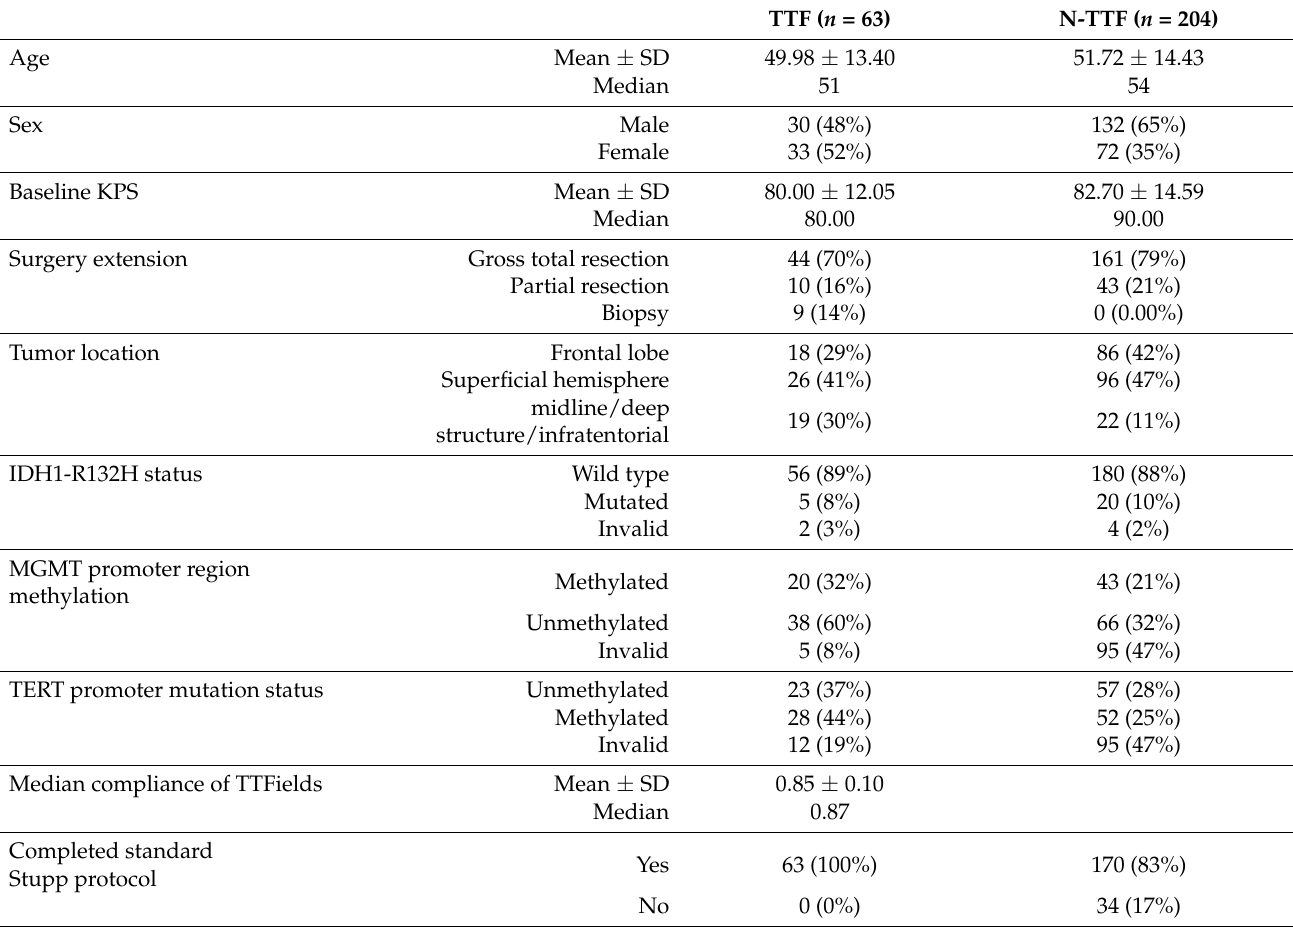
Table 1. Patient